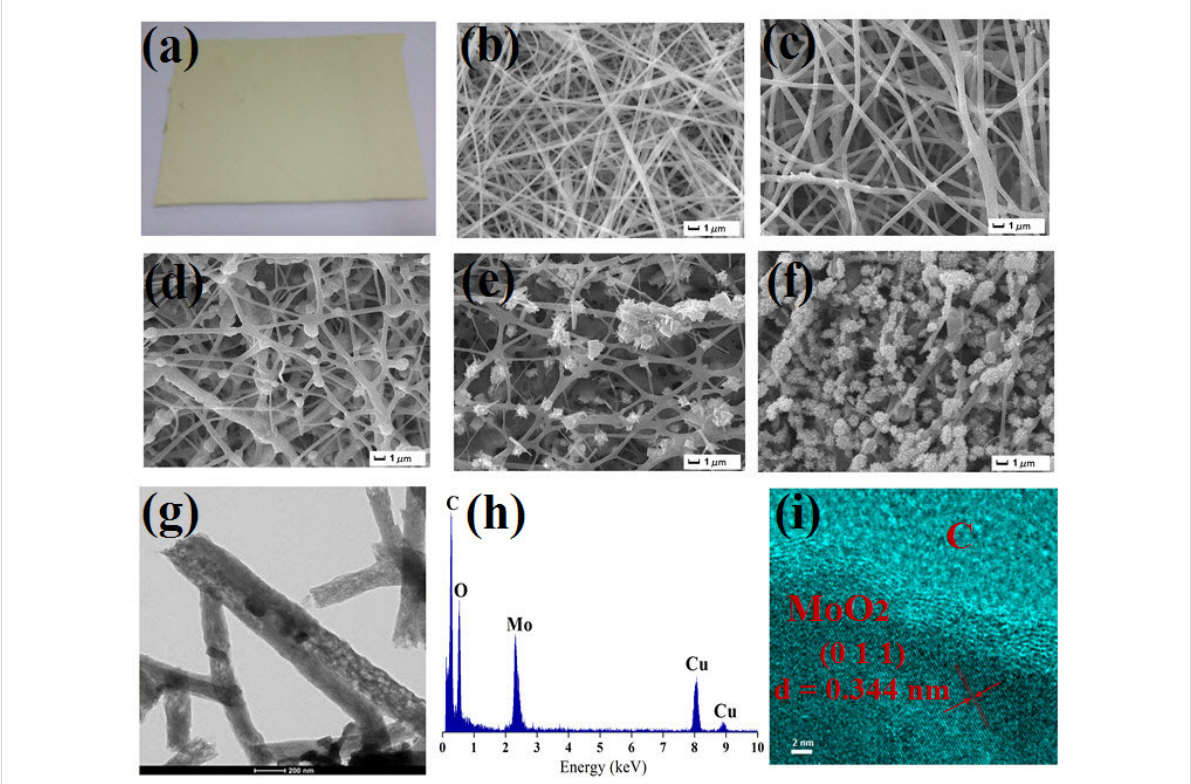
Figure 3: (a) A photo of nonwoven PAN/PMA fabric. SEM images of (b) as-prepared PAN/PMA composite fibers, (c-–f) fibers calcined at 550 °C, 650 °C, 750 °C and 850 °C. (g) TEM image of MoO 2 –CNF calcined at 850 °C. (h) EDX elemental line analysis and (i) HRTEM image of MoO 2 –CNFs.